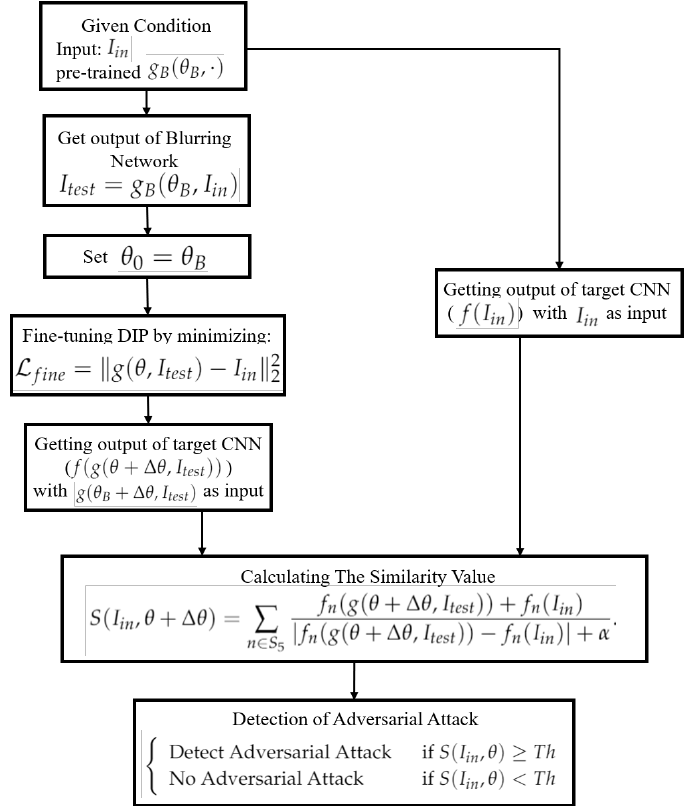
Figure 7. Flowchart of the proposed